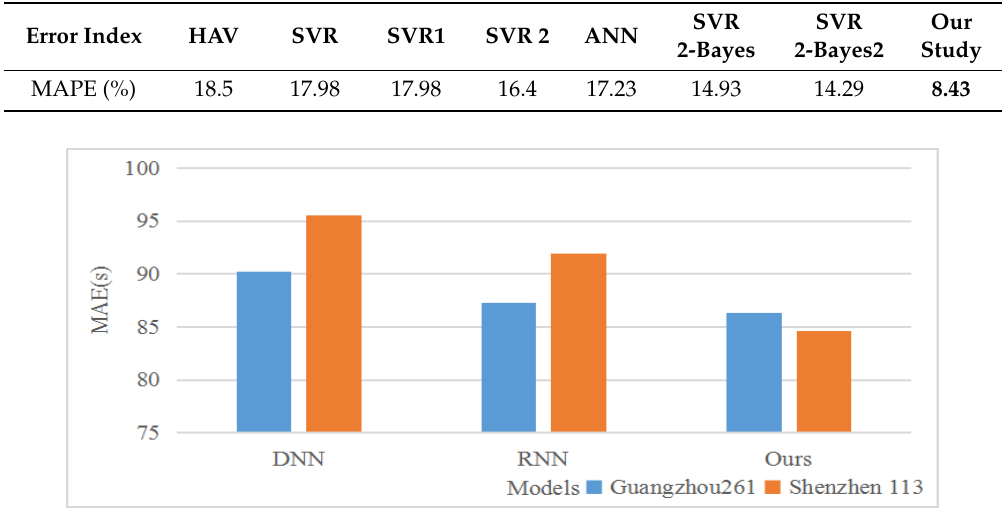
Table 3. Results for GuangZhou261.